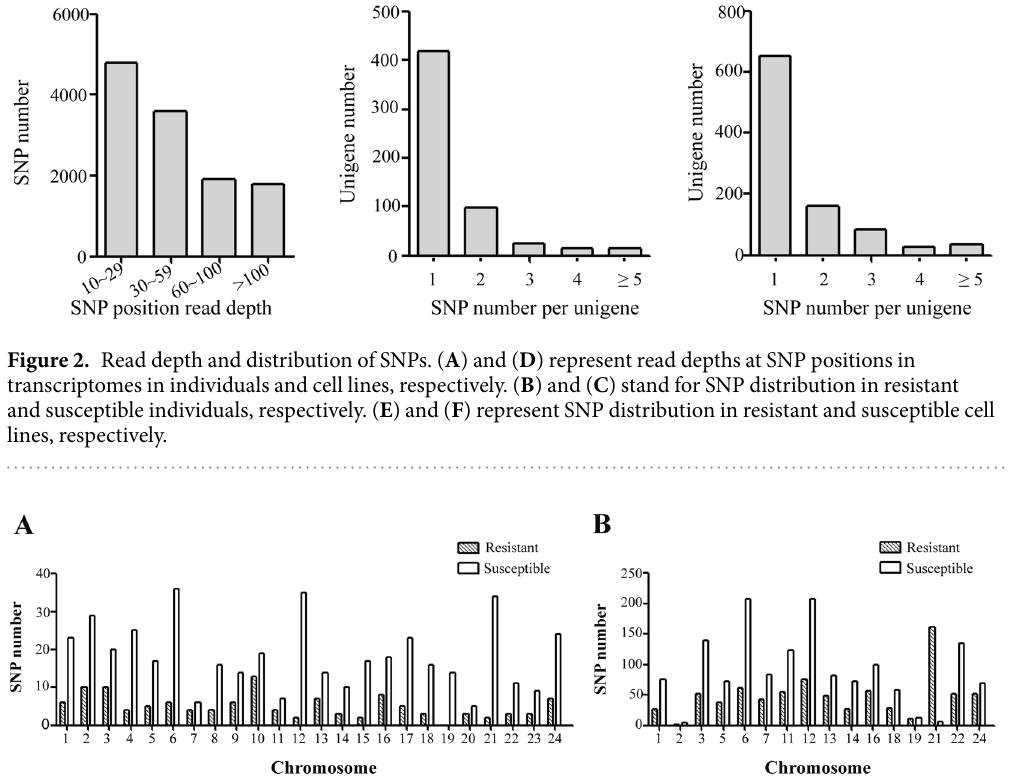
Figure 3. SNPs location in C. idella genome. 24 C. idella chromosomes are marked on the horizontal axis and the number of SNPs associated with resistance/susceptibility to GCRV is plotted on the vertical axis in individuals ( A ) and cell lines ( B ),